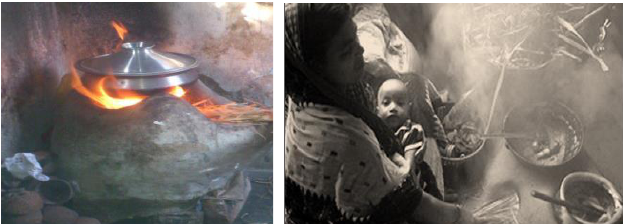
Figure 1. Typical example of a traditional biomass cooking stove [15] (reproduced with permission from Sowgath, 2015).